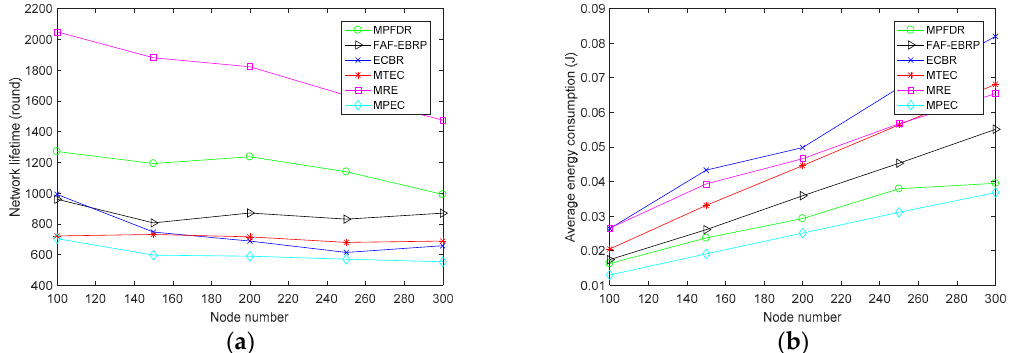
Figure 4. ( a ) NL versus different number of nodes; ( b ) AE versus different number of nodes.